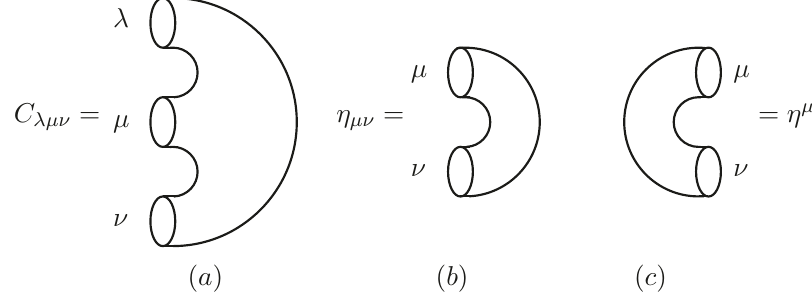
Figure 1 . ( a ): C λµν corresponds to a sphere with three left oriented holes. ( b ): η µν corresponds to a sphere with two left oriented holes. ( c ): η µν corresponds to a sphere with two right oriented holes.